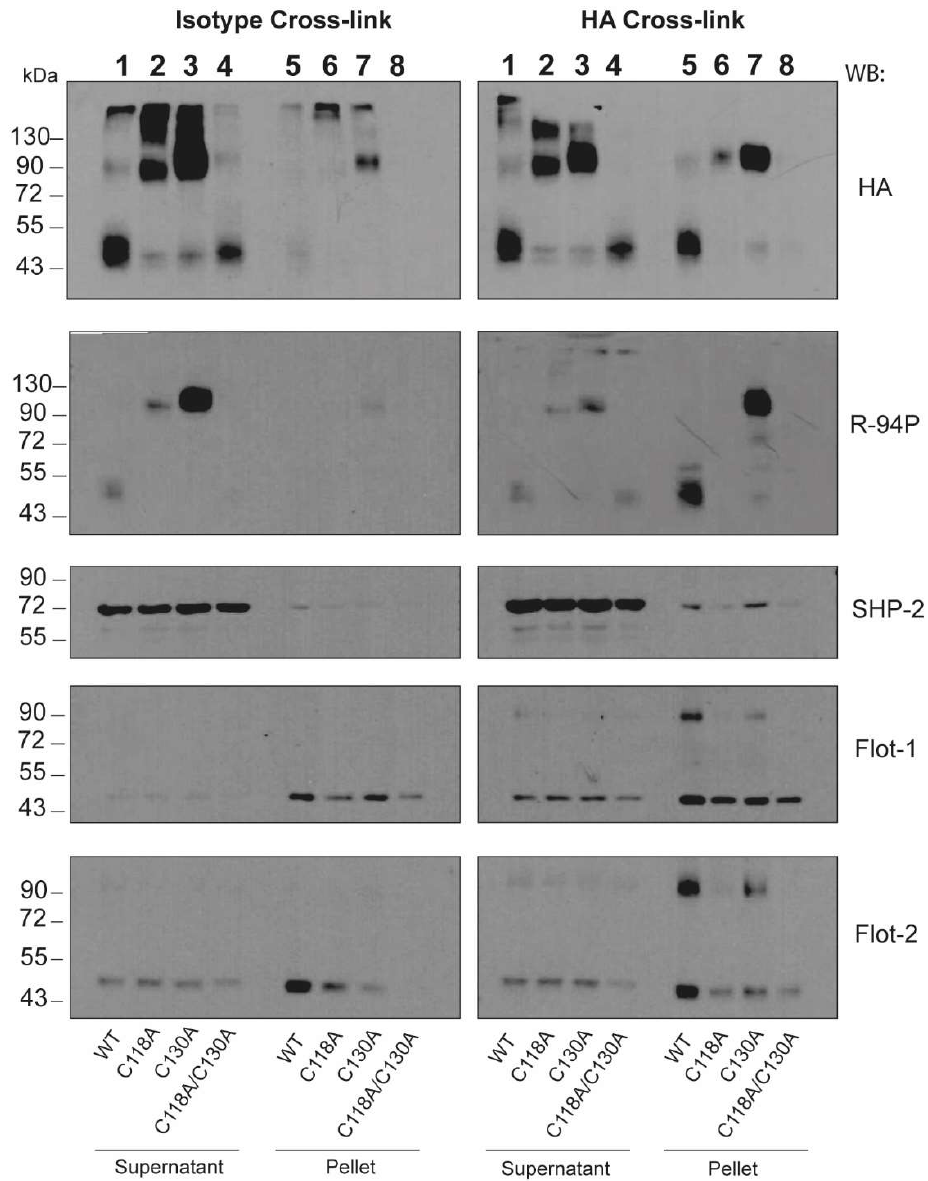
Figure 4. Involvement of neck domain C118 and C130 in early signaling initiated by antibody-induced clustering of CLEC12A. Wild-type (WT) and mutant CLEC12A expressed transiently in HEK-293T cells were cross-linked with an anti-HA or a mouse isotype (IgG) control antibody and a secondary (F(ab’) 2 antibody prior to cell lysis with NP-40 buffer as described in Materials and Methods. CLEC12A translocation was analysed by Western blot of the supernatant (SN) or pellet (P) with the R-94P, anti-HA, anti-SHP-2 or anti-flotillin-1 and 2 antibodies. The flotillin-1 protein was used a loading control. These data are representative of three independent experiments.